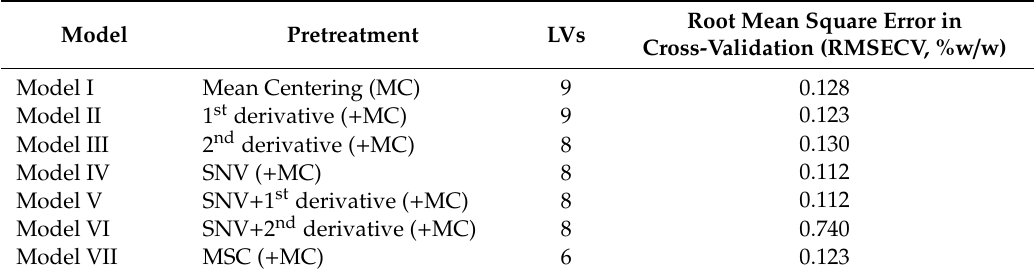
Table 4. PLS analysis. Cross-validated results on the calibration